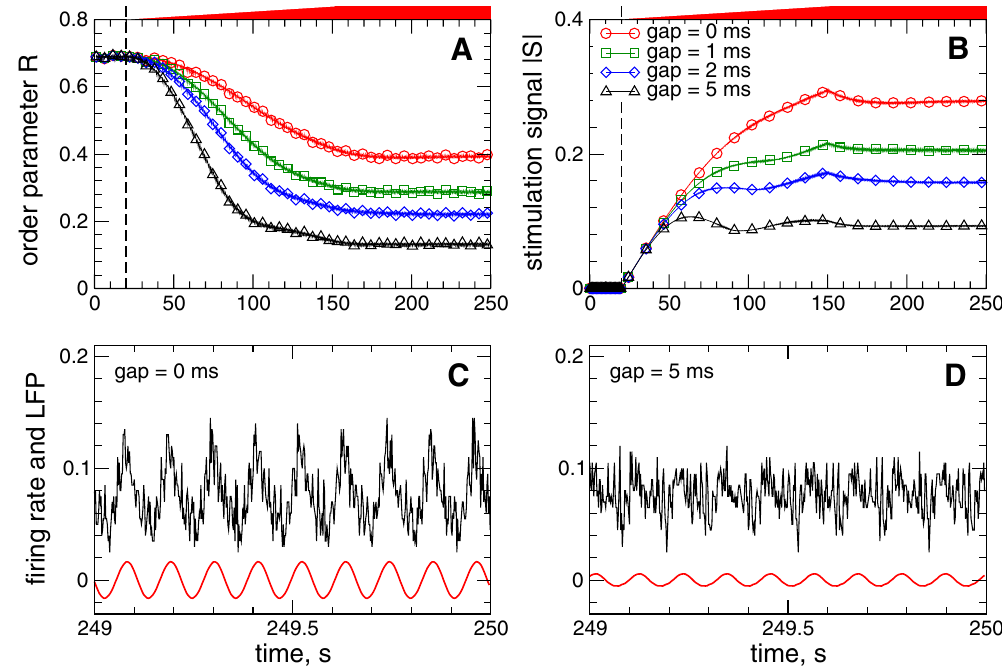
Figure 4. Suppression of synchronization in the neuronal ensemble (1) - (3) by pulsatile LDF stimulation (6). Time courses of ( A ) the order parameter R of STN neurons and ( B ) absolute value | S | of the feedback signal (6) are depicted for different widths of the interphase gap [Fig. 3B in Methods] as indicated in the legend in plot ( B ). Only local maxima of the oscillating signal | S | are shown in plot ( B ). The stimulation starts at t = 20 s indicated by vertical dashed lines, where the parameter of the stimulation intensity K linearly increases and reaches its maximal value K = 10 at t = 150 s as indicated by red bars on top of the plots. In plots ( C ) and ( D ) the corresponding time courses of the firing rate (black curves) and filtered LFP (red curves) are depicted for gap widths 0 ms and 5 ms as indicated in the plots. All simulations with stimulation delay τ = 70